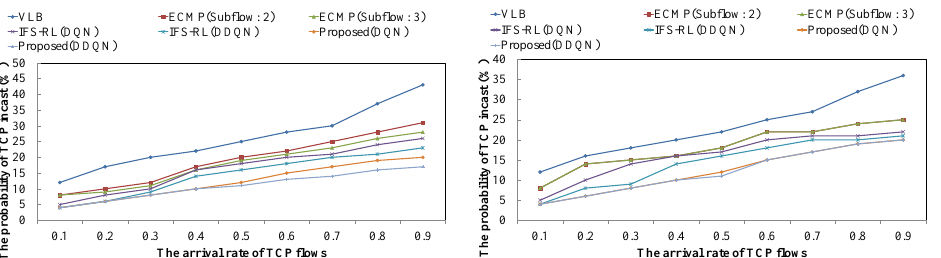
Figure 7. The probability of TCP incast occurrence against the arrival rate of TCP flows (( Left ): the case for complex architecture, ( Right ): the case for non-complex